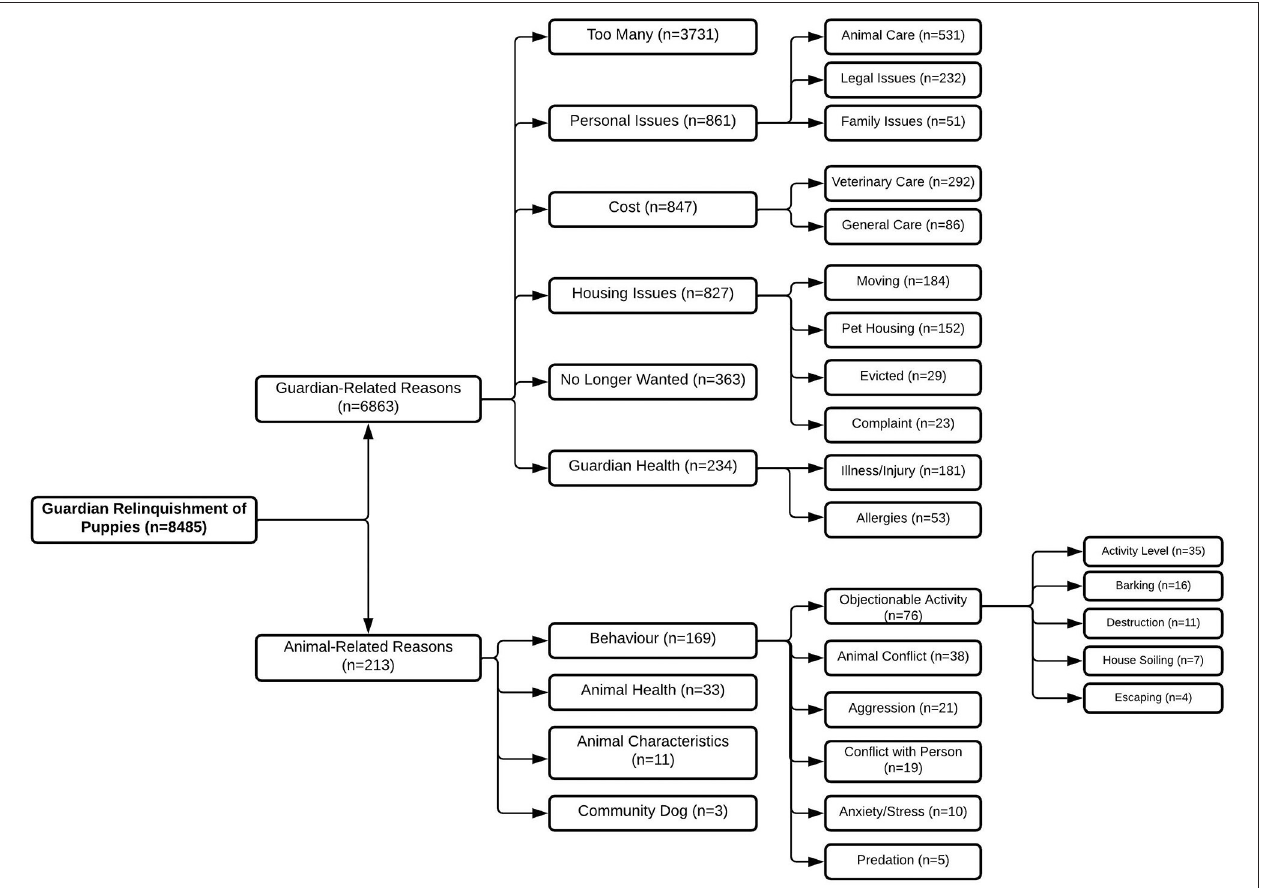
FIGURE 2 | The number of puppies relinquished to the BC SPCA between 2008 and 2019 ( n = 8,485). Relinquishment reasons include reasons relating to the guardian ( n = 6,863) and reasons relating to the animal ( n = 213). Where enough information was provided for further classification, the number of dogs and puppies relinquished for sub-reasons is